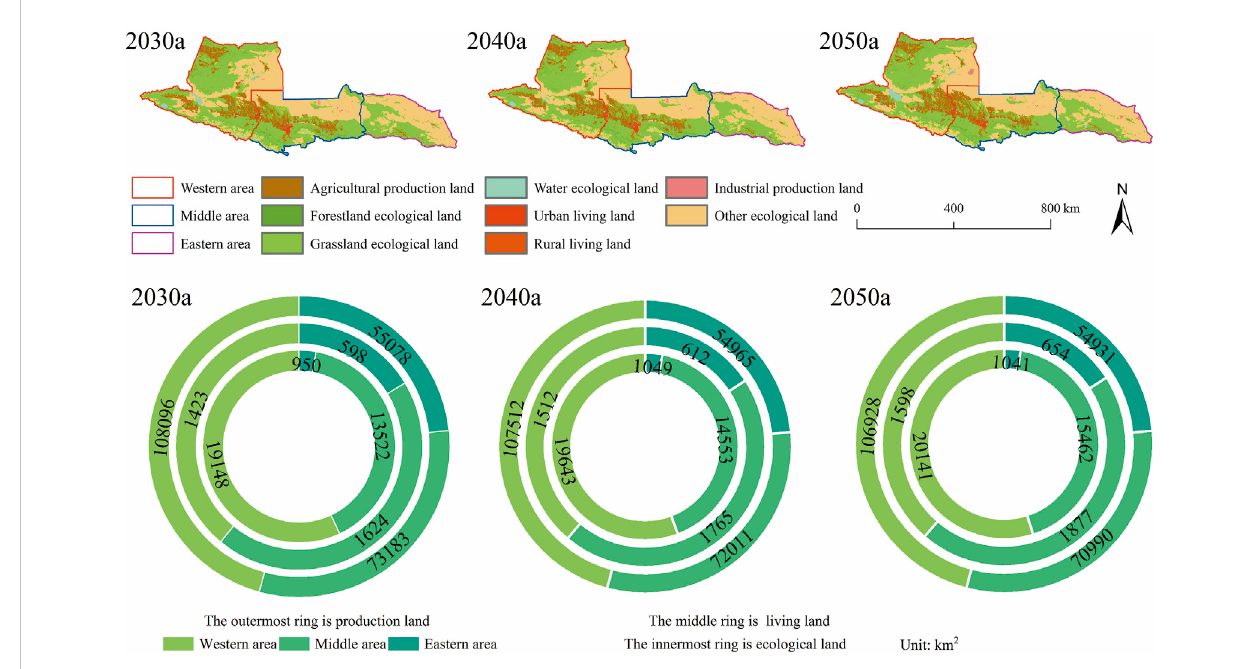
FIGURE 8 Land use distribution and area on the northern slopes of the Tianshan Mountains from 2030 to 2050.